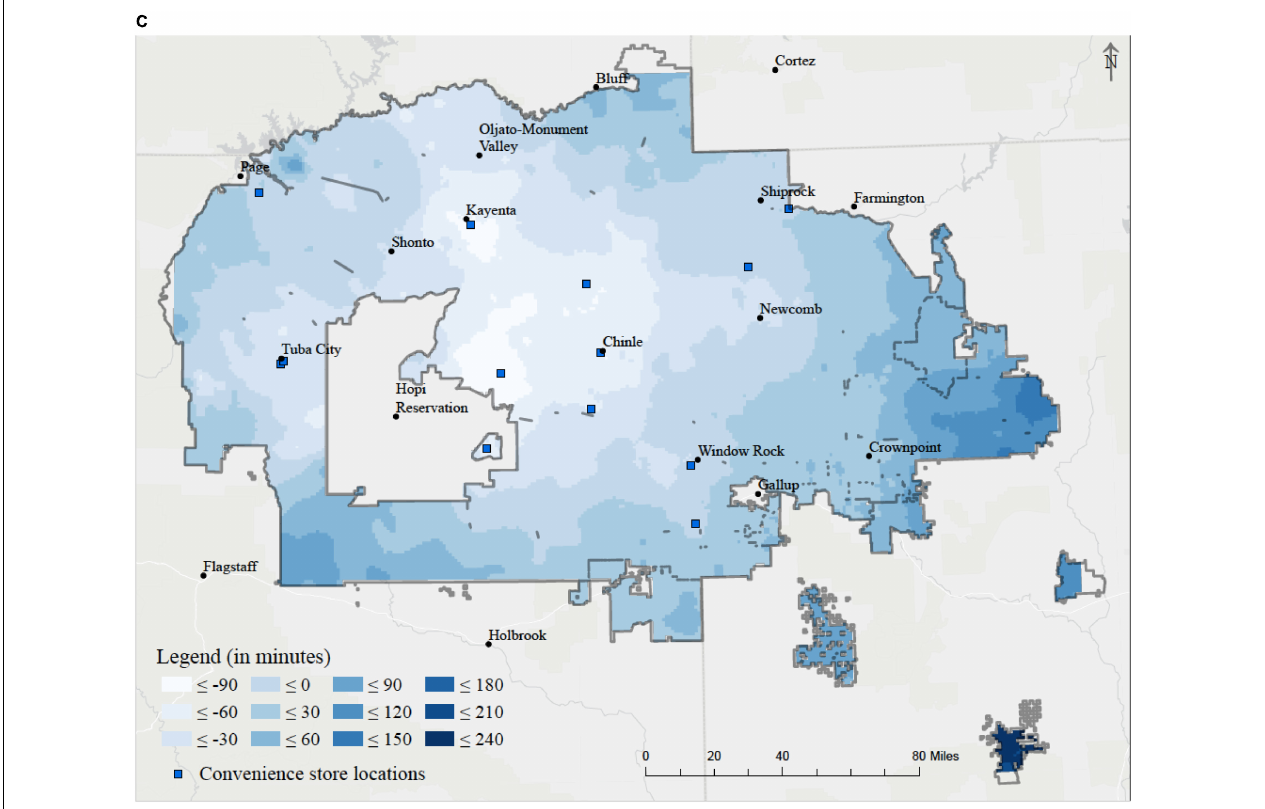
FIGURE 3 | Food store driving time differences between on and off the Navajo reservation by minutes. (A) Grocery driving time differences. (B) Restaurant driving time differences. (C) Convenience store driving time